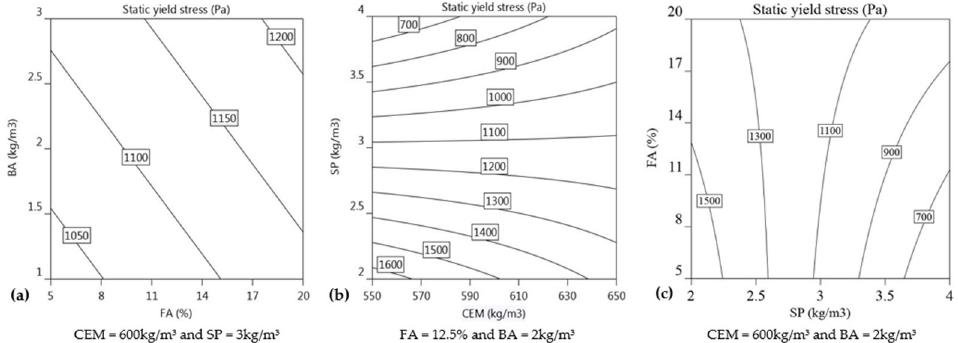
Figure 10. Isoresponse curves illustrating yield stress for ( a ) BA versus FA, ( b ) SP versus CEM, and ( c ) FA versus SP. ( c ) FA versus